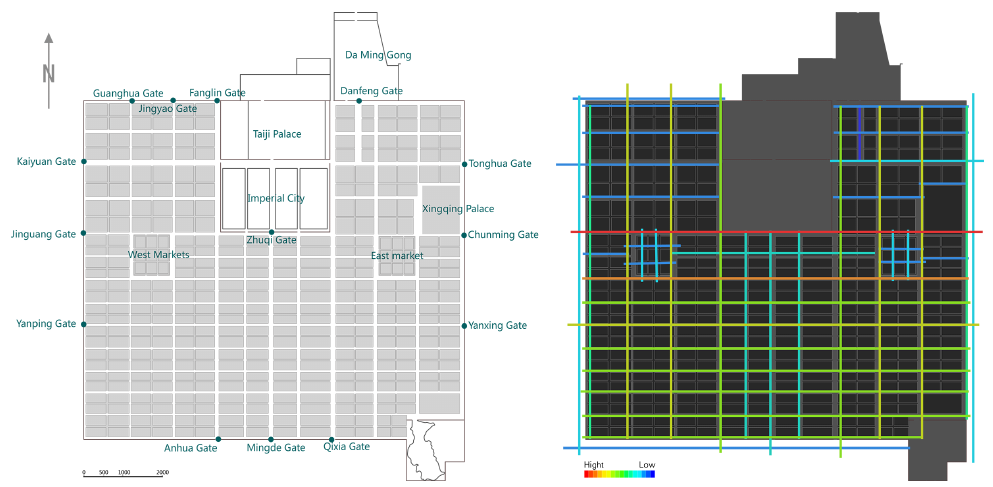
Figure 3. Global integration of the axes in Chang’an of the Tang Dynasty. According to the global integration value of the Dongjing City in Figure 4, there were four significant red axes, including the New Fengqumen Street to Mahang Street, the street from Liang Gate to Old Cao Gate, Bianhe Avenue and the South-north Street from Xingguosi Bridge to the Chongming Gate. These were the main roads with good accessibility to link the central and peripheral areas. These streets were densely populated with commercial shops, close to the political centre, which constitutes the core space of Dongjing. The degree of integration in the periphery of the capital city was low, which may be because the outer city was planned with more military barracks and granaries located close to the outer city gates or water gates. This resulted in a less dense distribution of the road network, with poor accessibility and reduced population concentration compared to the commercial areas of the inner city.